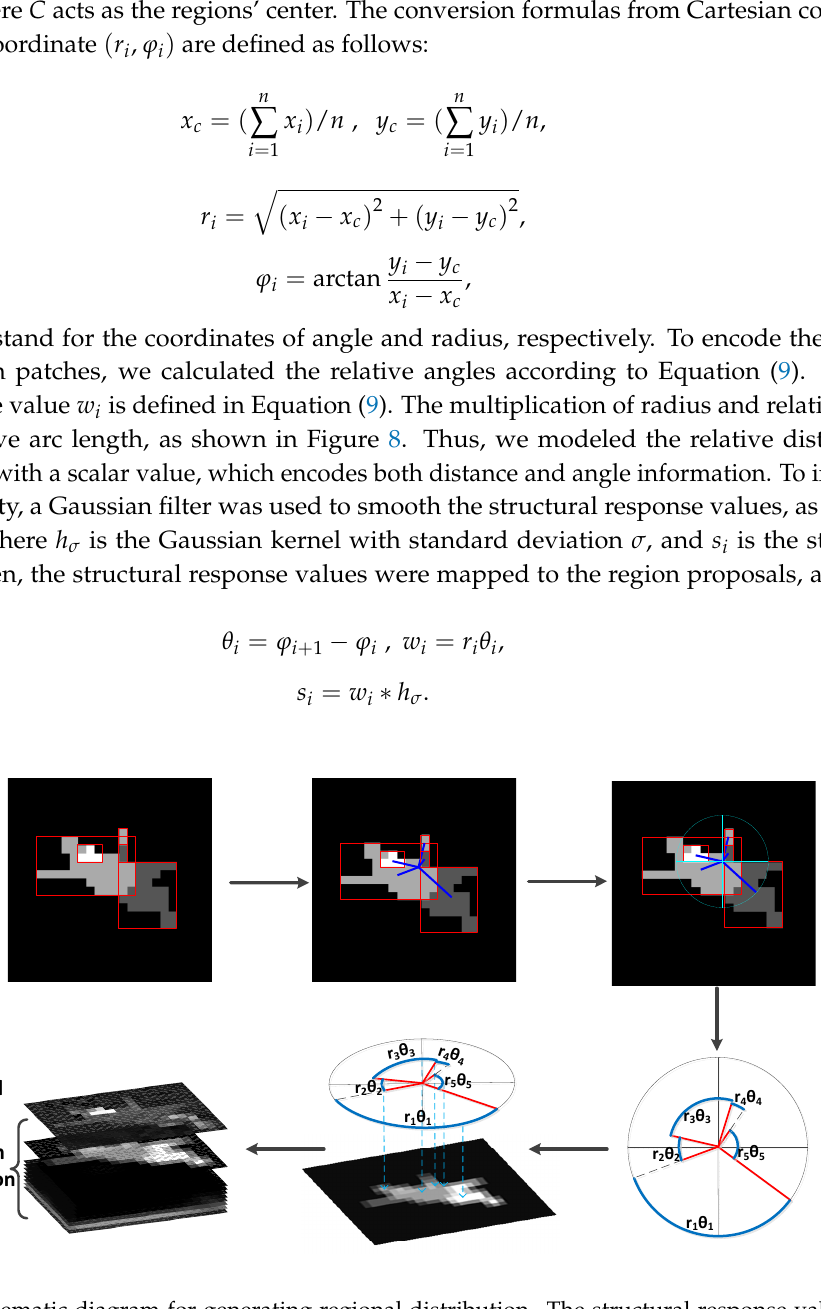
Figure 8. Schematic diagram for generating regional distribution. The structural response values, encoding the relative position between patches, were performed in polar coordinates and mapped to corresponding patches. Then the structural feature map is obtained and integrated into the distribution field to generate regional